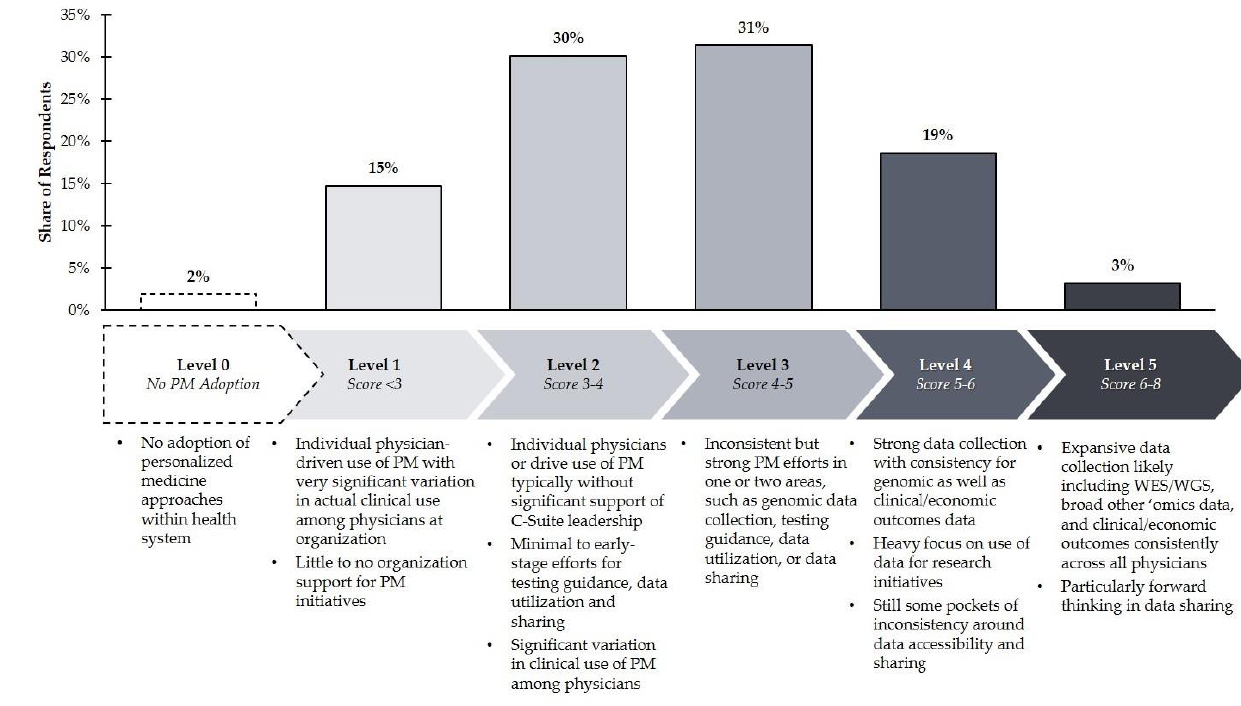
Figure 3. US health system distribution of the overall level of personalized medicine integration.